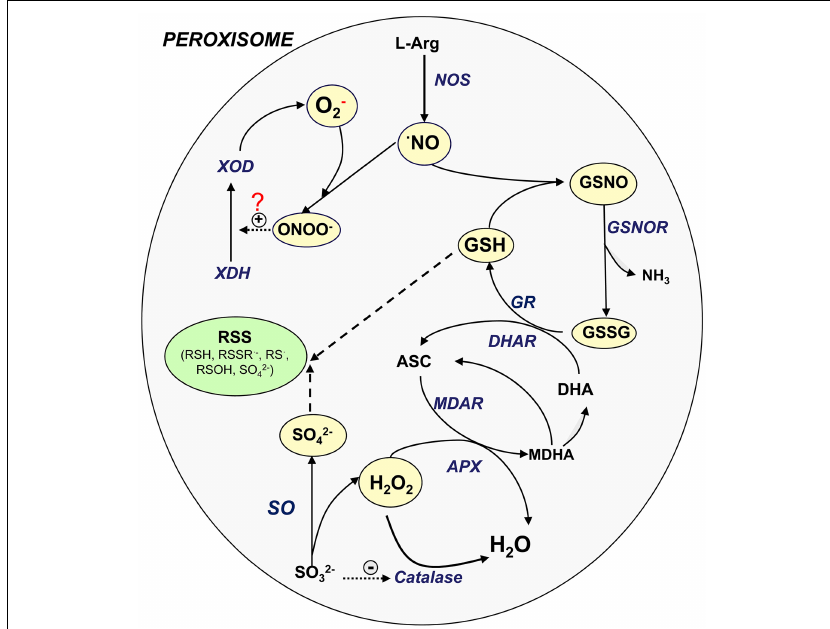
FIGURE 1 | Signaling cross-talk between NO, ROS, and RSS. Model of the interaction amongst the different ROS, RNS, and sulfur metabolism into plant peroxisomes. ASC, ascorbate, reduced form; DHA, ascorbate, oxidized form (dehydroascorbate); GSH, glutathione, reduced form; GSNOR, nitrosoglutathione reductase; GSSG, glutathione, oxidized form; NO, nitric oxide; NOS, L-arginine-dependent nitric oxide synthase; MDAR, monodehydroascorbate reductase; ONOO − , peroxinitrite; SO, sulfite oxidase; XDH, xanthine dehydrogenase; XOD, xanthine oxidase; RSS, reactive sulfur species; RSH, thiol; RSSR ·− , disulfide radical; RS · , thyl radical; ROSH, sulfenic acid; SO 2 − 4 ,